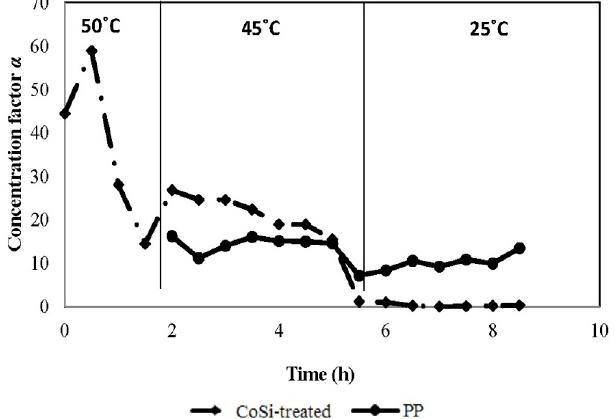
Figure 6. Concentration factors α of CoSi-treated and PP membranes along operation